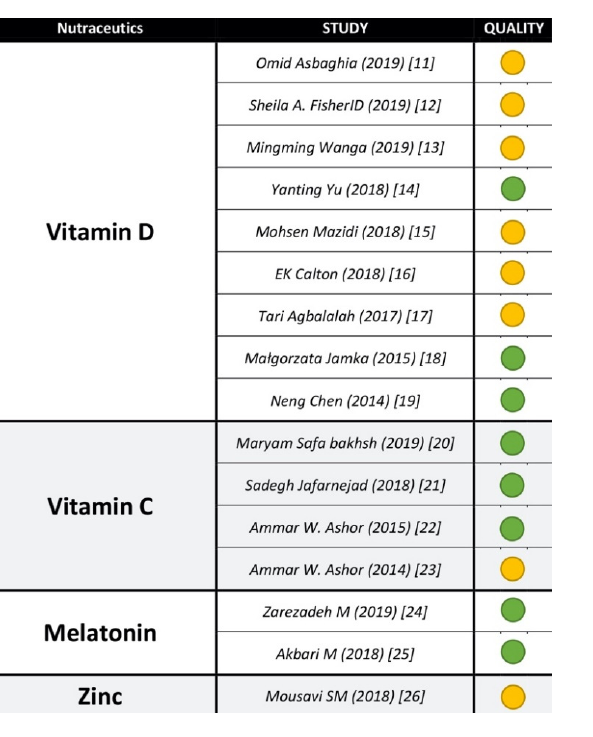
Figure 2. A Measurement Tool to Checklist Assess Systematic Reviews (AMSTAR) assessment for each systematic review, sorted by year of publication. Colors are referred to scores: green is re- ferred to “high scores” (8–11 points) and yellow to “moderate” (4–7 points). No systematic review had a “low” (<3 points)